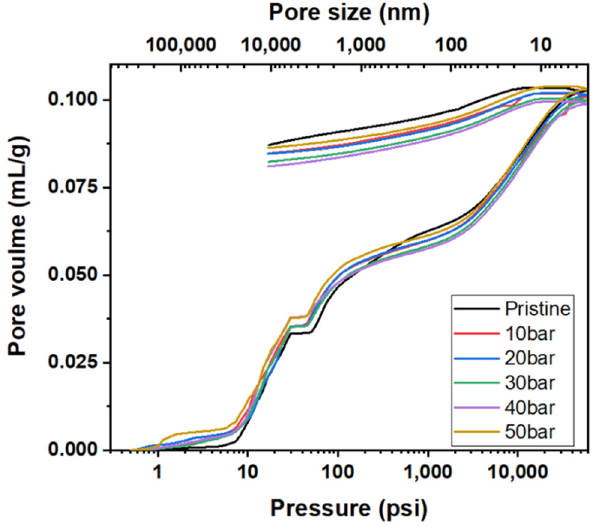
Figure 8. Mercury intrusion and extrusion curves of graphite blocks before and after impregnation at various pressures.